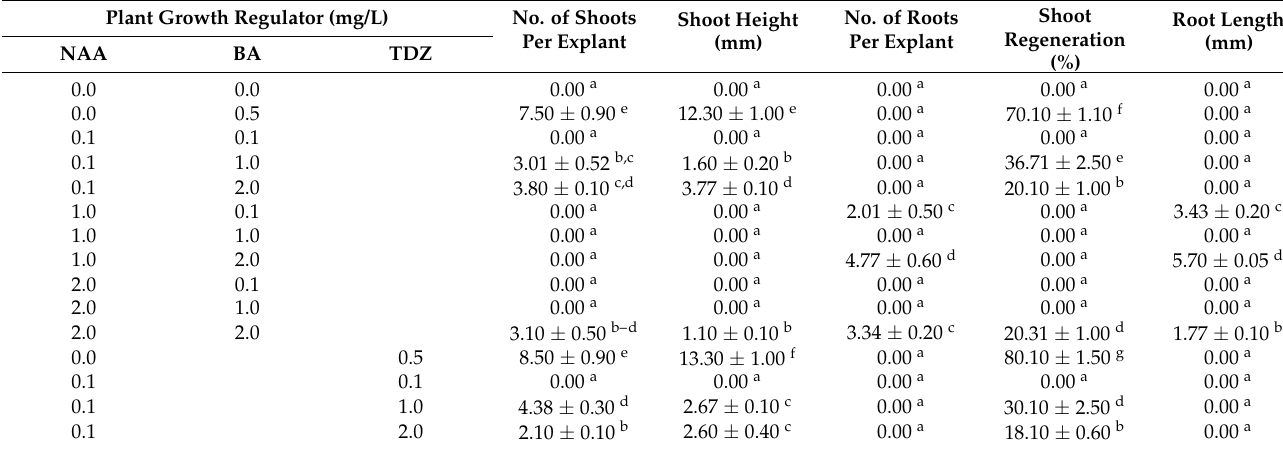
Table 1. Influence of different plant growth regulators on direct adventitious shoot regeneration from leaves of L. chinense after six weeks of culture. Plant Growth Regulator (mg/L)